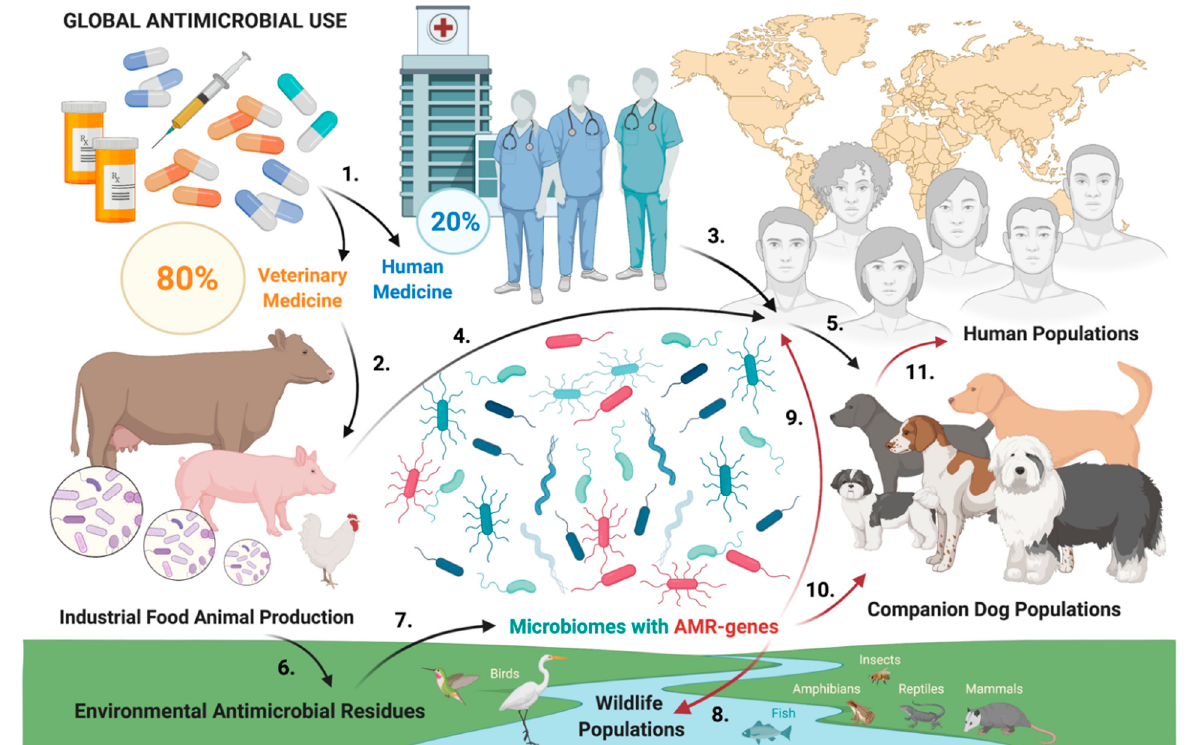
Figure 2. Public health exposure paths in global antimicrobial use. Total antimicrobial use is distributed approximately 80% vs. 20% between veterinary and human medicine, respectively (1). A majority of veterinary antimicrobial use (2) is allocated towards industrial food animal production (IFAP), which contains an estimated 99% of all farmed animals. A significant amount of antimicrobial exposure in people therefore happens through paths other than the intake of prescription drugs from human healthcare providers (3). Consumption of animal-derived products from IFAP also entails ingestion of antimicrobial residues for both humans (4) and their companion dogs (5). Dogs are also prescribed antimicrobials from veterinary clinicians, but this use is minimal compared to IFAP. Waste from IFAP, moreover, results in the release of antimicrobial residues (6) and other contaminants into the environment. Excessive antimicrobial use and environmental antimicrobial residues fuel the development of microbiomes with varying levels of resistances (7), at an alarming rate and scale. The resulting antimicrobial resistance (AMR) constitutes a health hazard for wildlife (8), humans (9), and companion-dog populations (10). The presence of microbiomes with AMR genes in dogs, including a canine urinary resistome, comprise an additional risk factor that could spill over into human populations (11). Created with BioRender.com.